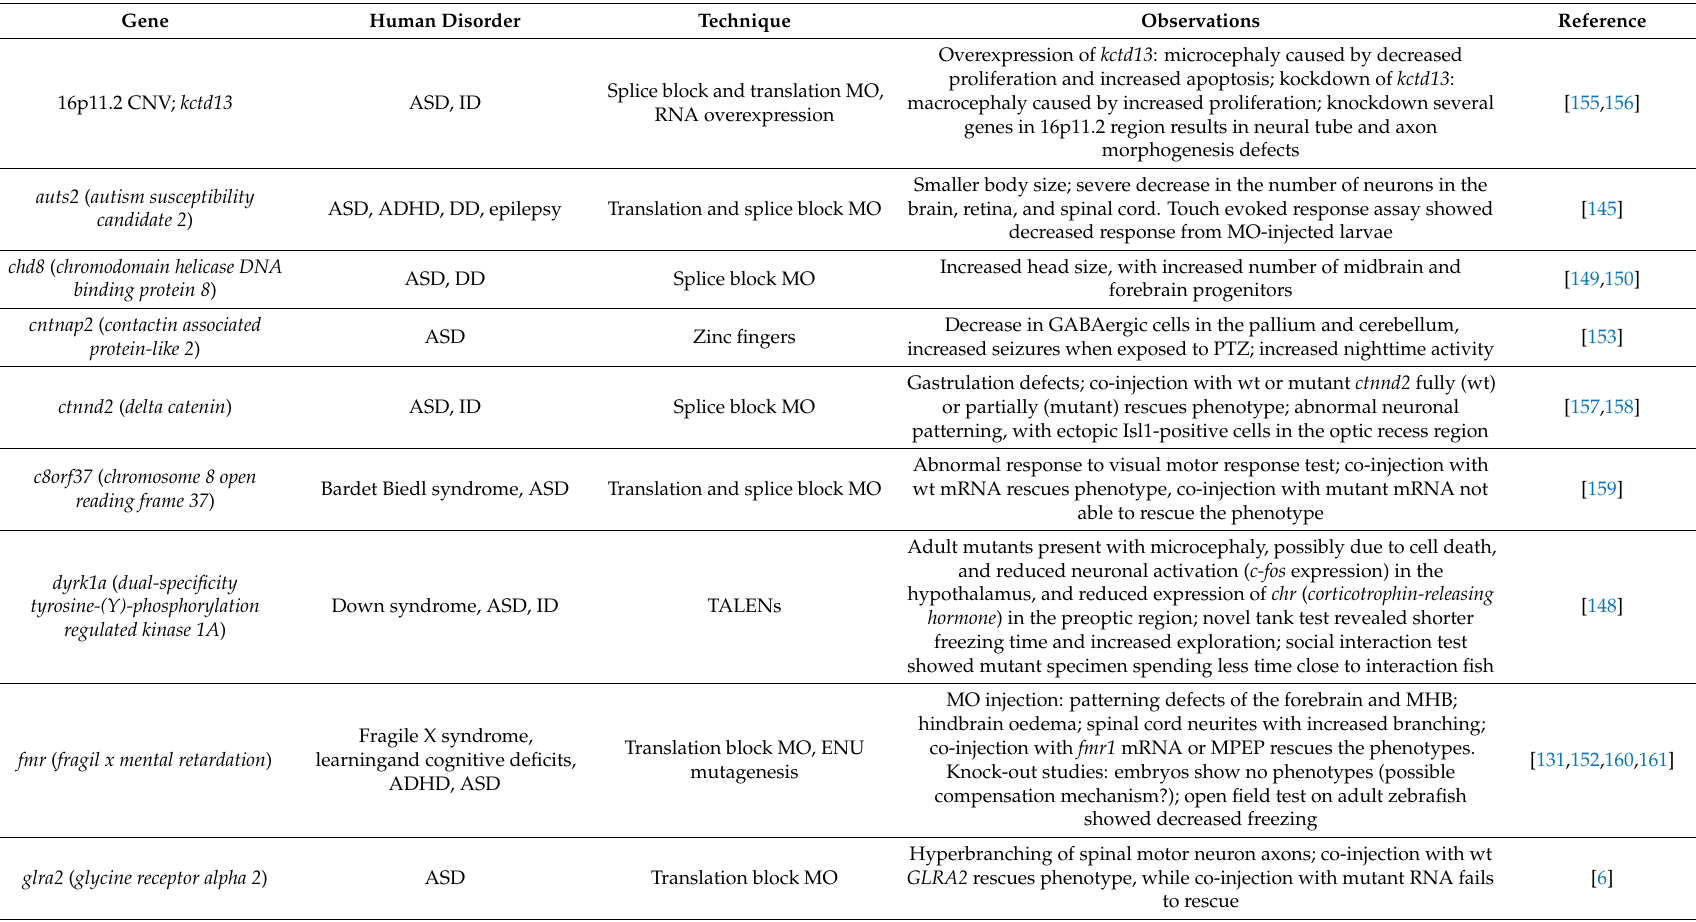
Table 2. Zebrafish genetic models of neurodevelopmental